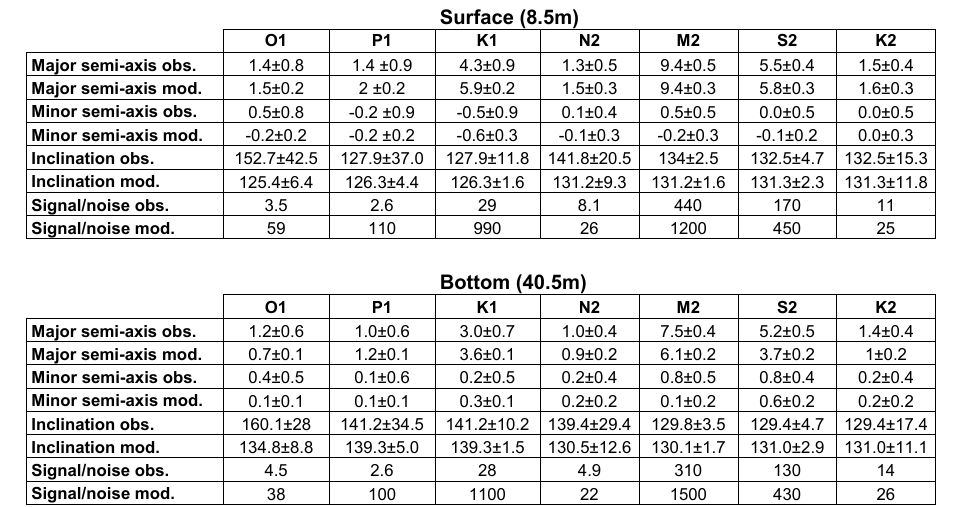
Table 4. Tidal-ellipse parameters for the seven major tidal constituents from observed (obs) and modelled (mod) data at the station J and two depths. Inclination angles are in degrees and semi-axes in cm/s.